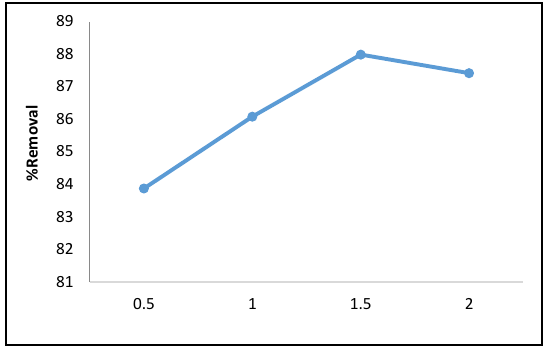
Fig. 9. The removal efficiency Ni (II) by ferrous sulfate at different ferrous sulfate dosages